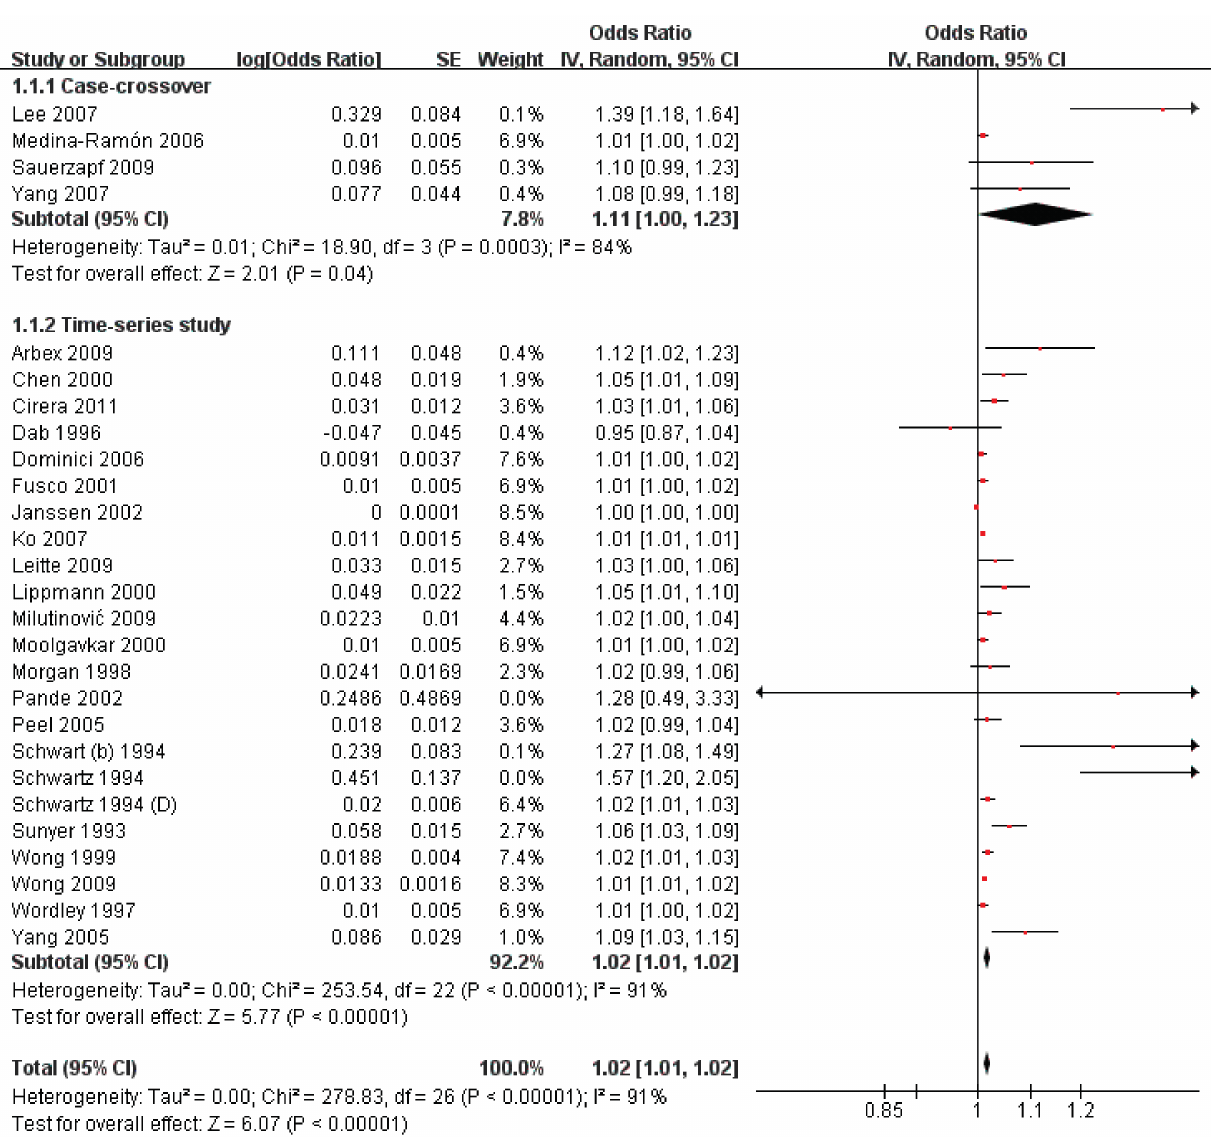
Figure 3. The effect of outdoor air pollution on COPD hospital